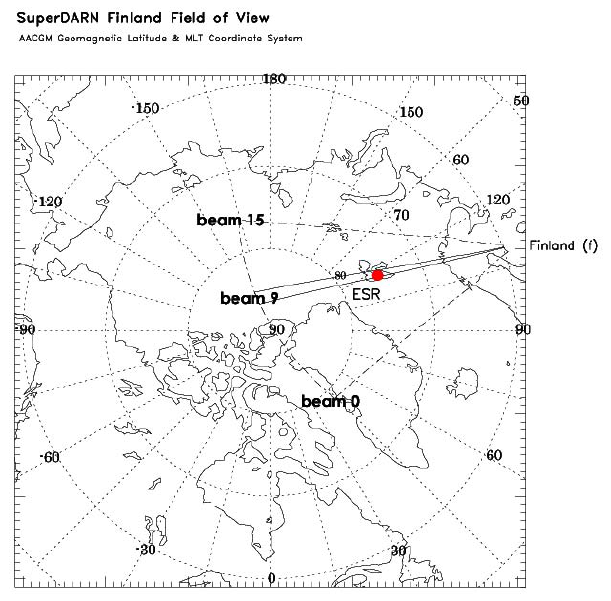
Fig. 2. Location of the ESR site at Longyearbyen (circle dot) and the field of view of the CUTLASS Finland radar in the geomagnetic latitude and MLT coordinate system. The field of view of the CUT- LASS Finland radar consists of 16 beams (Beam 0-15), with Beam 9 over the ESR site.